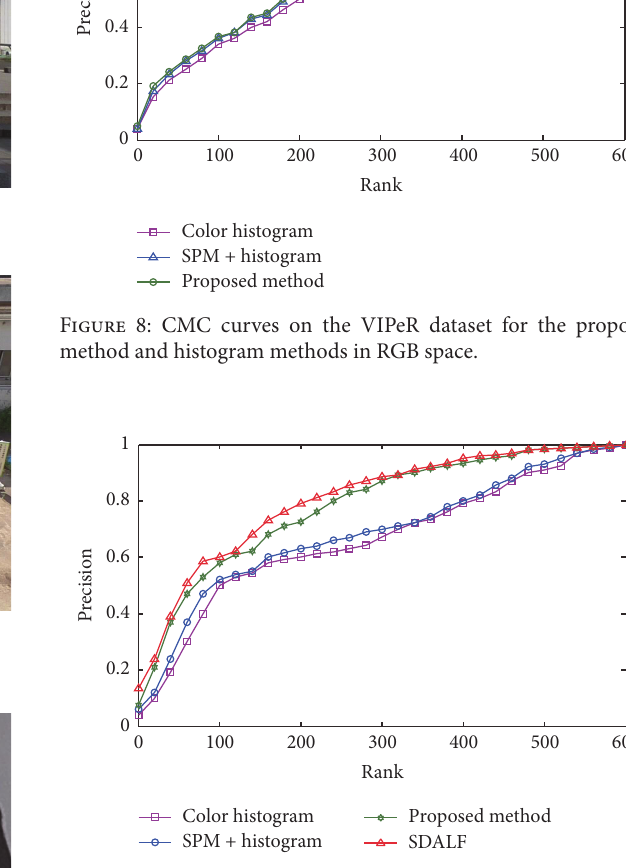
Figure 9: CMC curves on the VIPeR dataset for the proposed method and the other methods in HSV